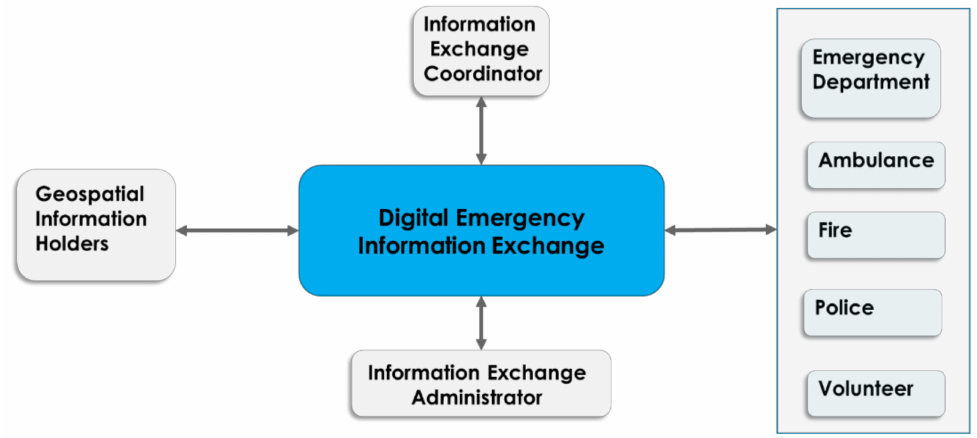
Figure 5. Deployable digital emergency information